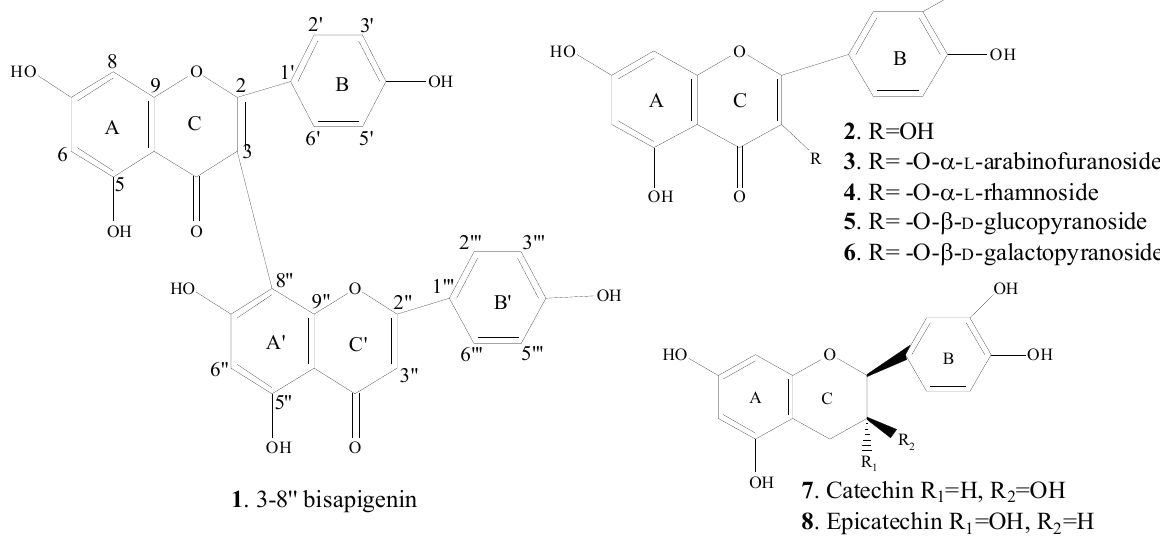
Figure 1. Structures of isolated compounds 1 – 8